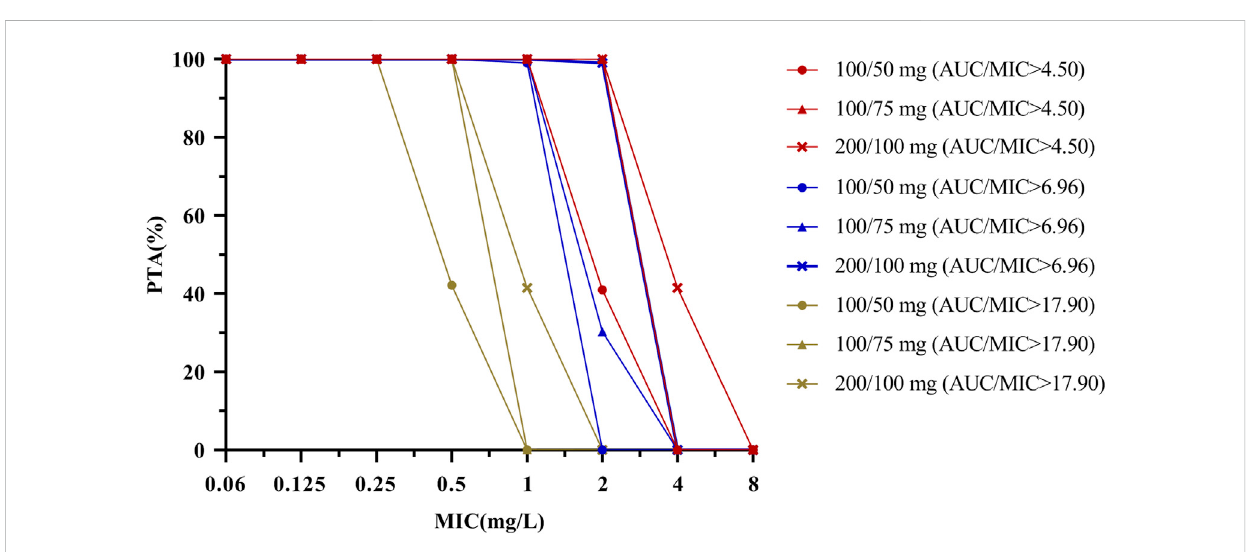
FIGURE 4 PTA by MIC for simulations of different dosing regimens of tigecycline for a PK/PD target of AUC 0 – 24 /MIC ≥ 4.5, 6.96 and 17.9. The PK/PD target is achieved when the probability of target attainment (PTA) is 90% coverage. PK parameter uncertainty (see Table 2) should be considered when using this fi